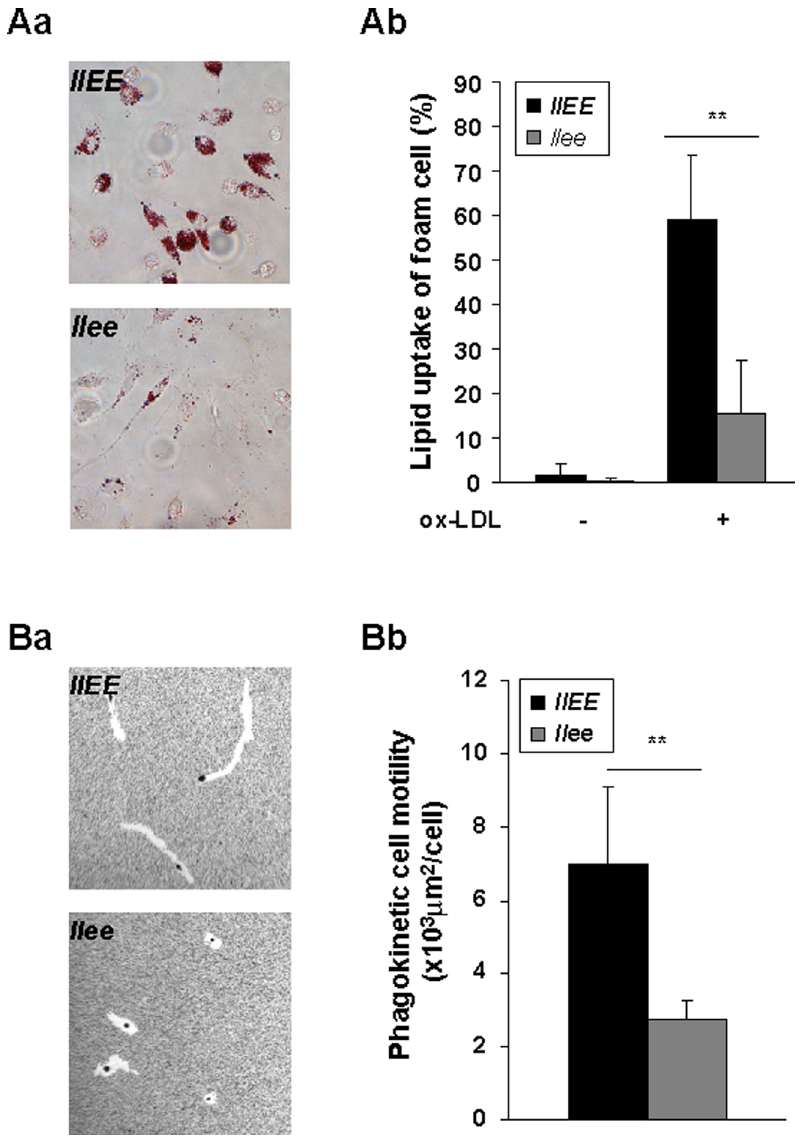
Figure 1. Lipid uptake of foam cells, and motility of bone marrow-derived macrophages. A , Lipid uptake of foam cells from peritoneal macrophages of either ldlr 2 / 2 ( llEE ) or ldlr 2 / 2 /C/EBP e 2 / 2 ( llee ) mice. ( a ) Representative foam cells in the presence of ox-LDL (25 m g/ml, 16 hrs) ( 6 40 magnification) are shown. ( b ) Quantification of A(a) in llEE (Black, n=5) and llee mice (Gray, n=7). Foam cells are expressed as a percentage of positive Oil red O cells compared with total macrophages. B , Phagokinetic cell motility assay using bone marrow-derived macrophages from either llEE or llee mice ( 6 10 magnification). ( a ) Representative formation of particle-free phagokinetic track on the gold monolayers. ( b ) Quantification of B(a) in llEE (Black, n=3) and llee mice (Gray, n=4). Particle-free motility tracks are measured as an indication of their phagokinetic movement. Data represent mean 6 SD. ** P , 0.01.